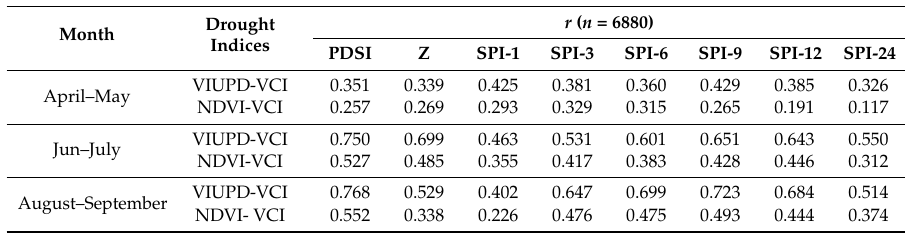
Figure 5. Spatial distribution of climate divisions with correlations (r-value) between VIUPD and NDVI-derived VCIs, and in situ drought indices for the three sub-periods from April to September. The sub-figure ( a ) stands for the correlations (r-value) from April to May; the sub-figure ( b ) stands for the correlations (r-value) from June to July, sub-figure ( c ) stands for the correlations (r-value) from August to September. Table 6. Comparisons between VIUPD and NDVI-derived VCIs in different sub-periods of the growing season.